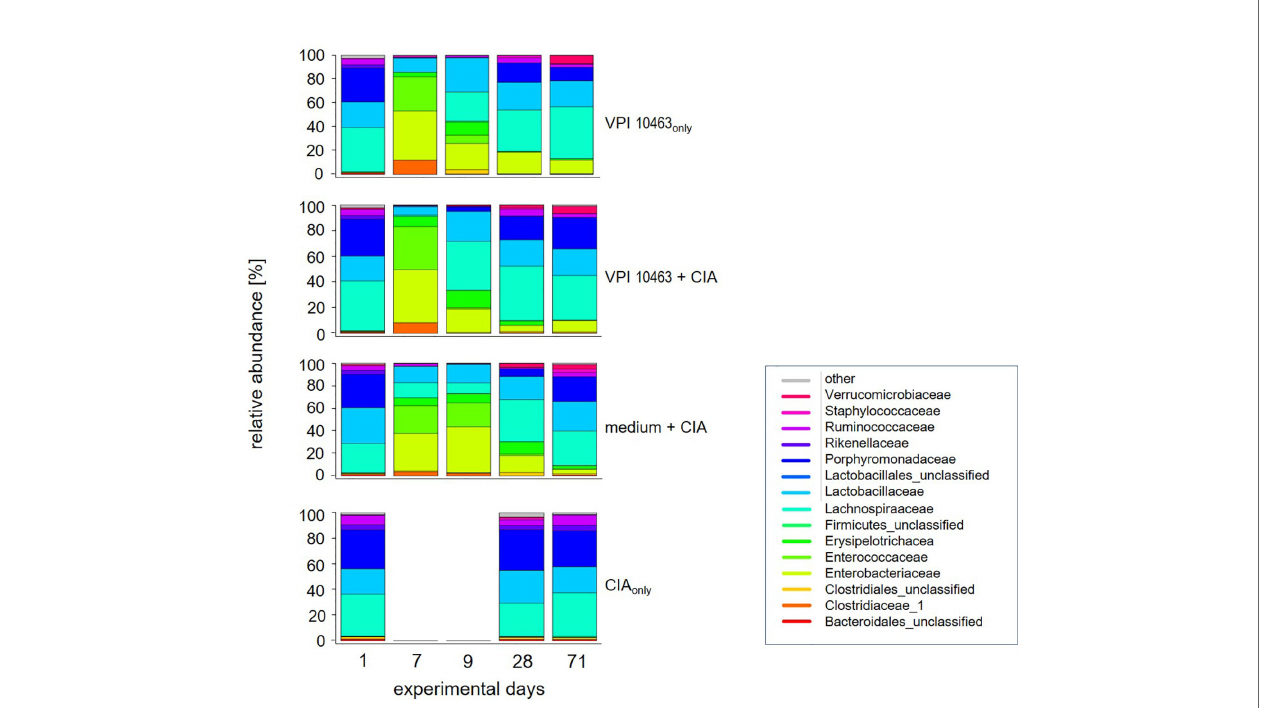
FIGURE 3 | VPI 10463 infection accelerates the reversal towards the original microbiome after antibiotics treatment. Stacked bar plots show relative abundancies of bacterial species in stool samples on experimental days 1, 7, 9, 28 and endpoint for the various experimental